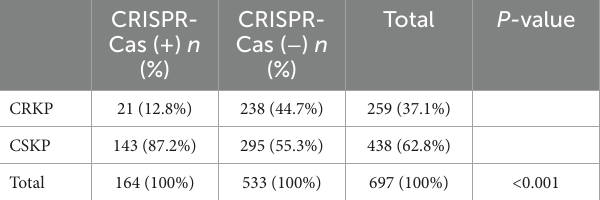
TABLE 2 The association of carbapenem-susceptibilities with CRISPR- Cas systems in clinical isolates of Klebsiella pneumoniae